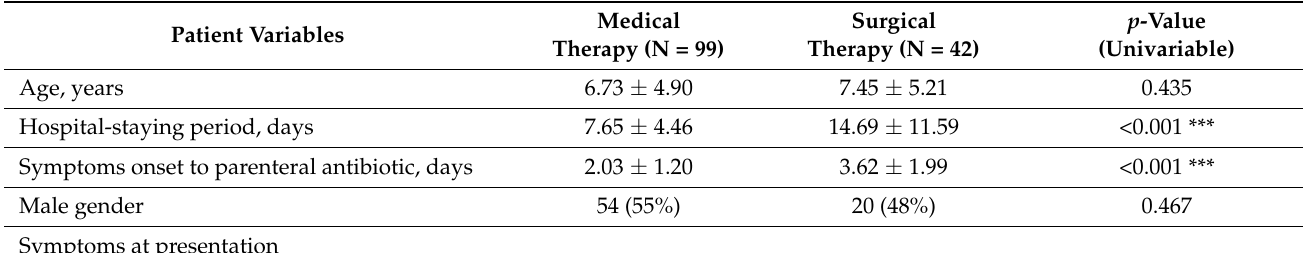
Table 3. Factors associated with surgical